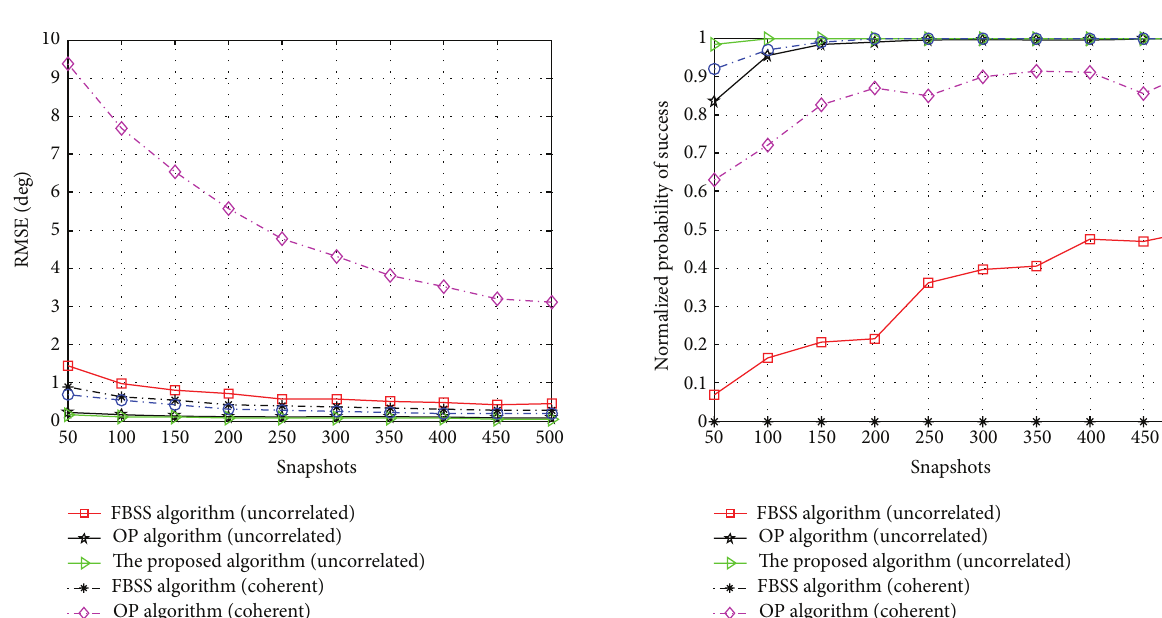
FBSS algorithm (uncorrelated) OP algorithm (uncorrelated) The proposed algorithm (uncorrelated) FBSS algorithm (coherent)